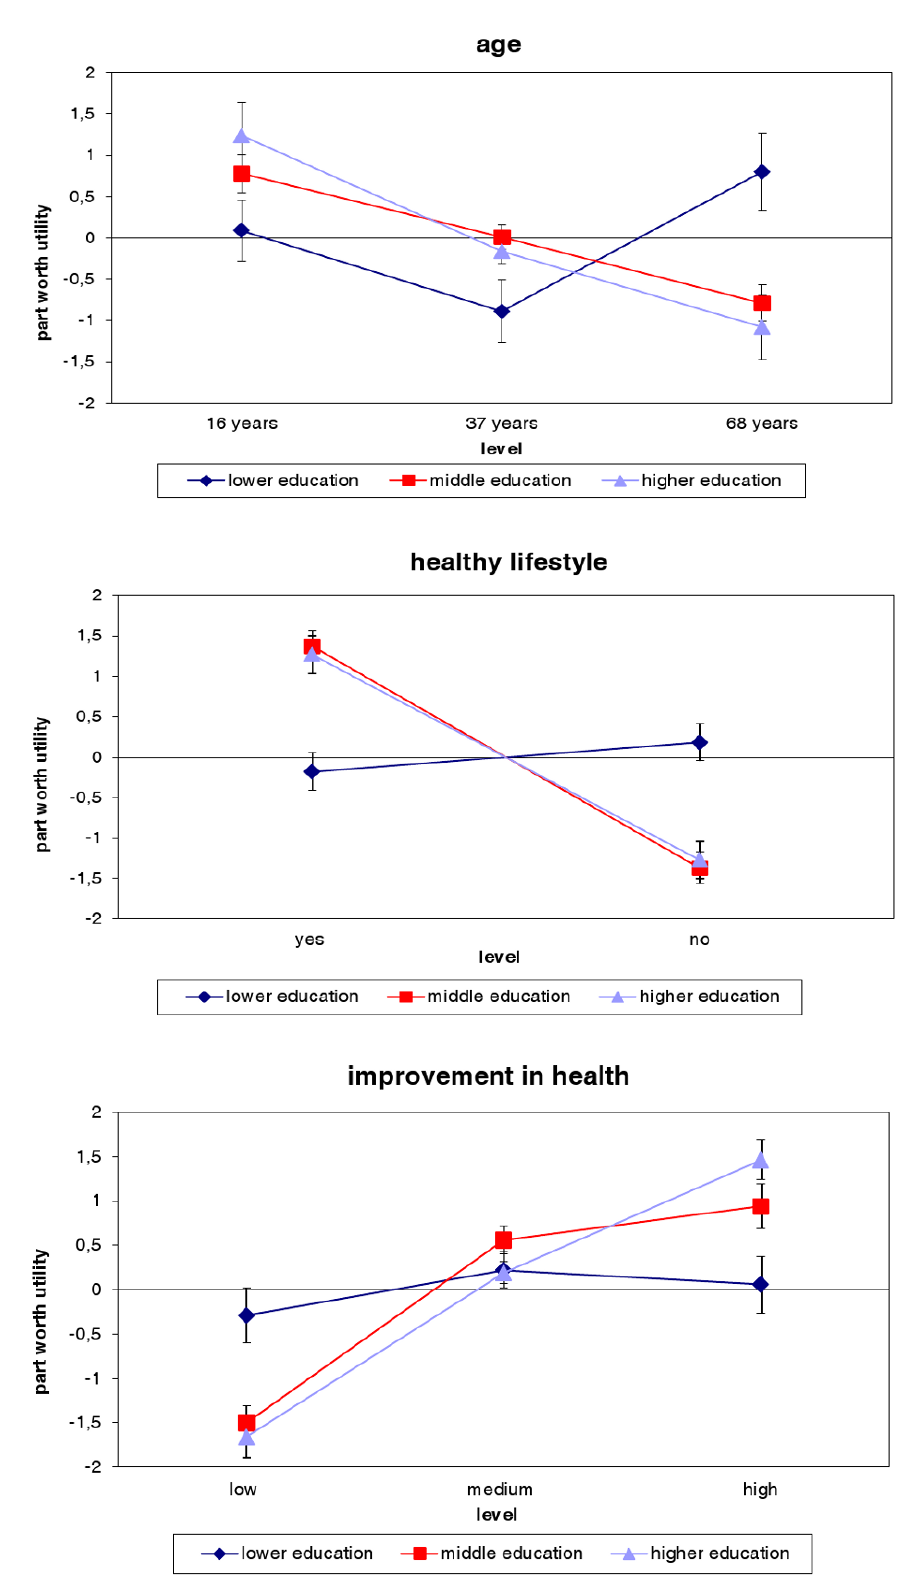
Figure 1. Part-worth utilities estimated for participants with lower, middle and higher education